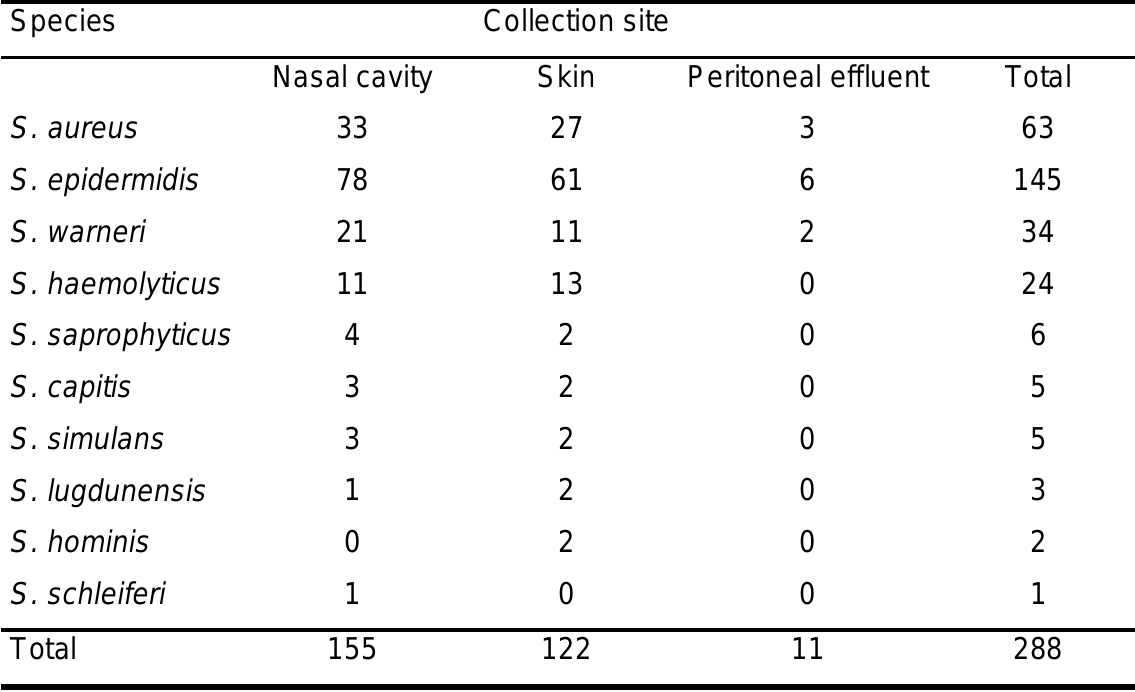
Table 2: Distribution of Staphylococcus strains isolated from the nasal